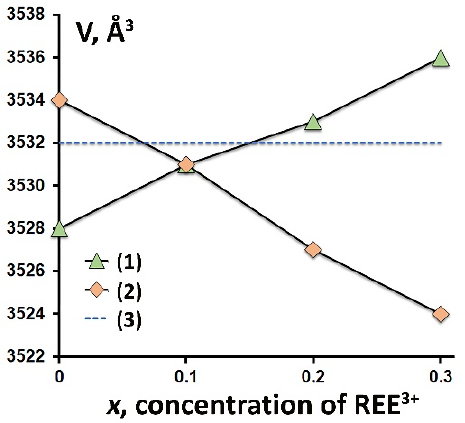
Figure 2. Figure 2. Dependence of the unit cell volumes of Ca 9 Gd 0.9 − x Tm 0.1 Sm x (PO 4 ) 7 (1) and